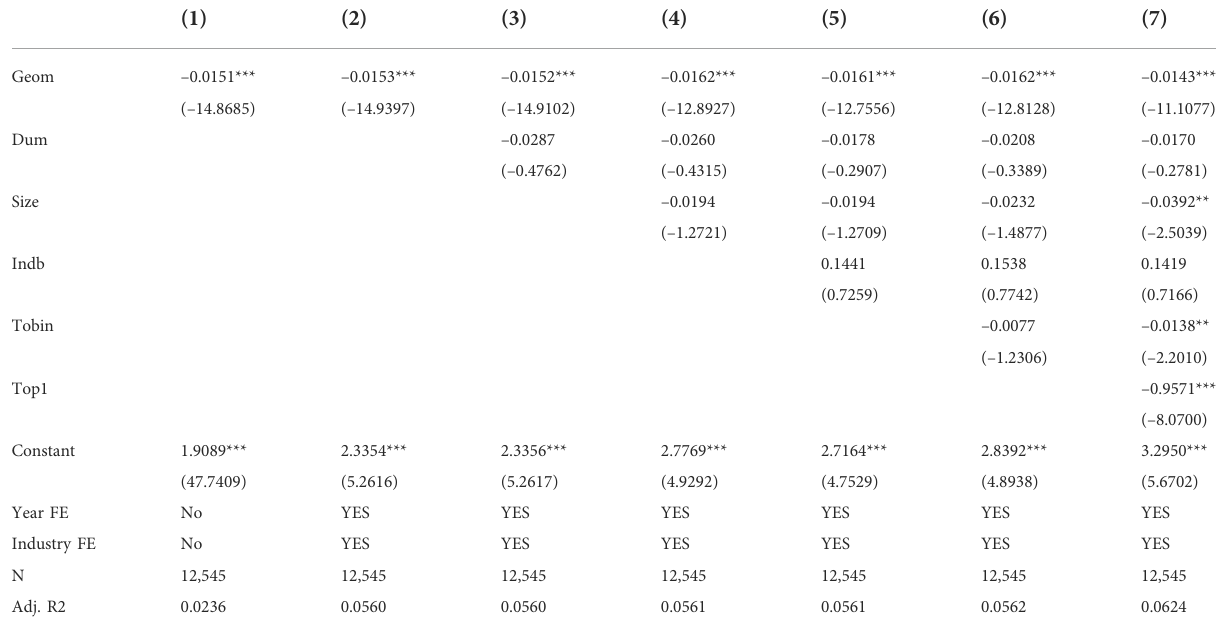
TABLE 7 Replace the air pollution variable.